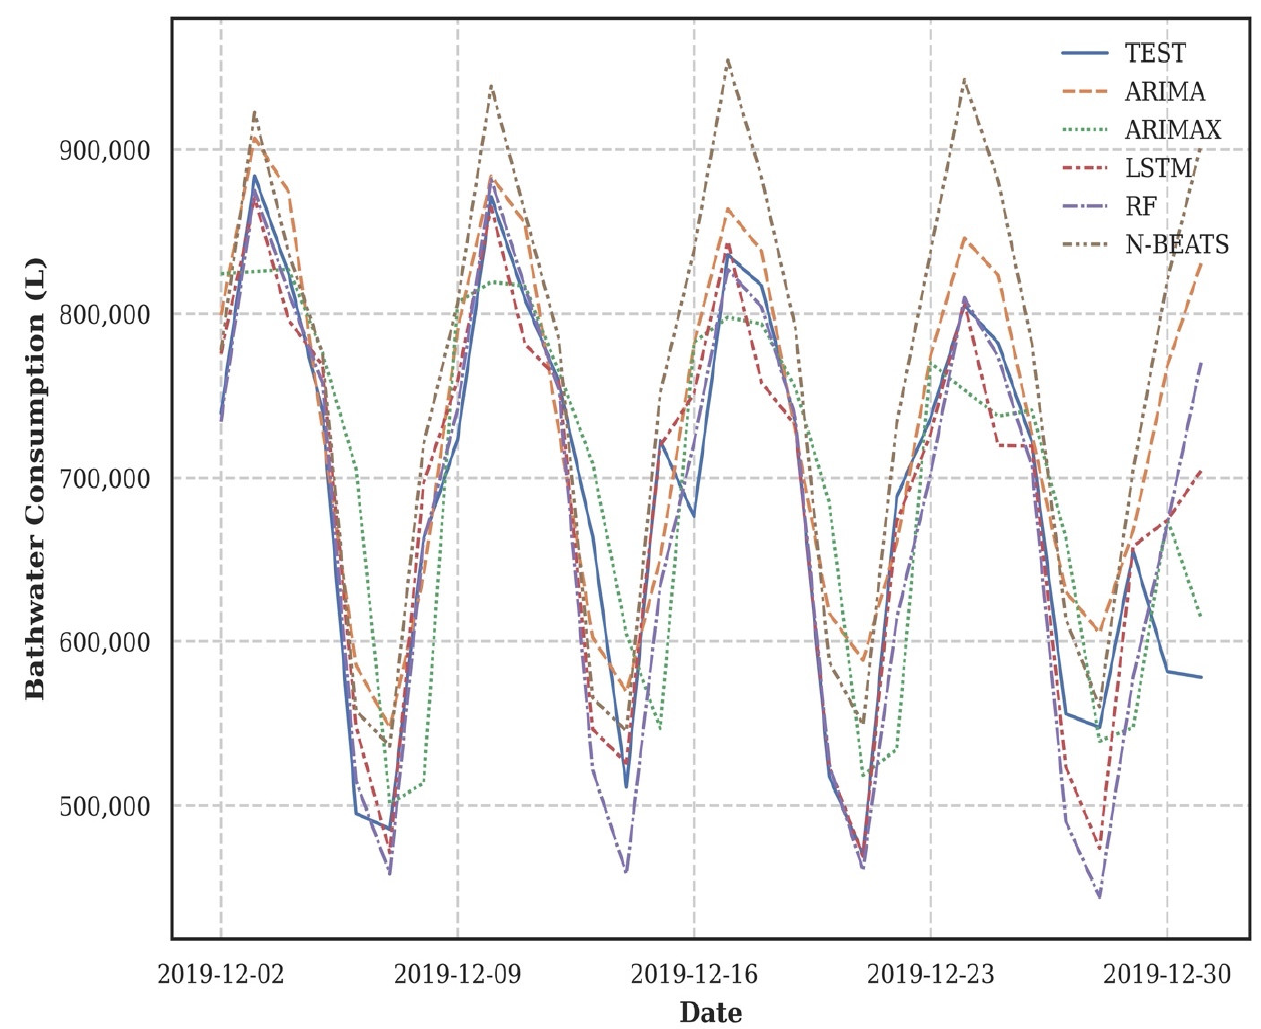
Figure 7. Daily total BWD forecast results using ARIMA, ARIMAX, LSTM, RF, and N-BEATS models. Table 4. MAPE-based performance evaluation of ARIMA, ARIMAX, LSTM, N-BEATS, and RF mod- els (bold denotes correct findings for the corresponding shower room).